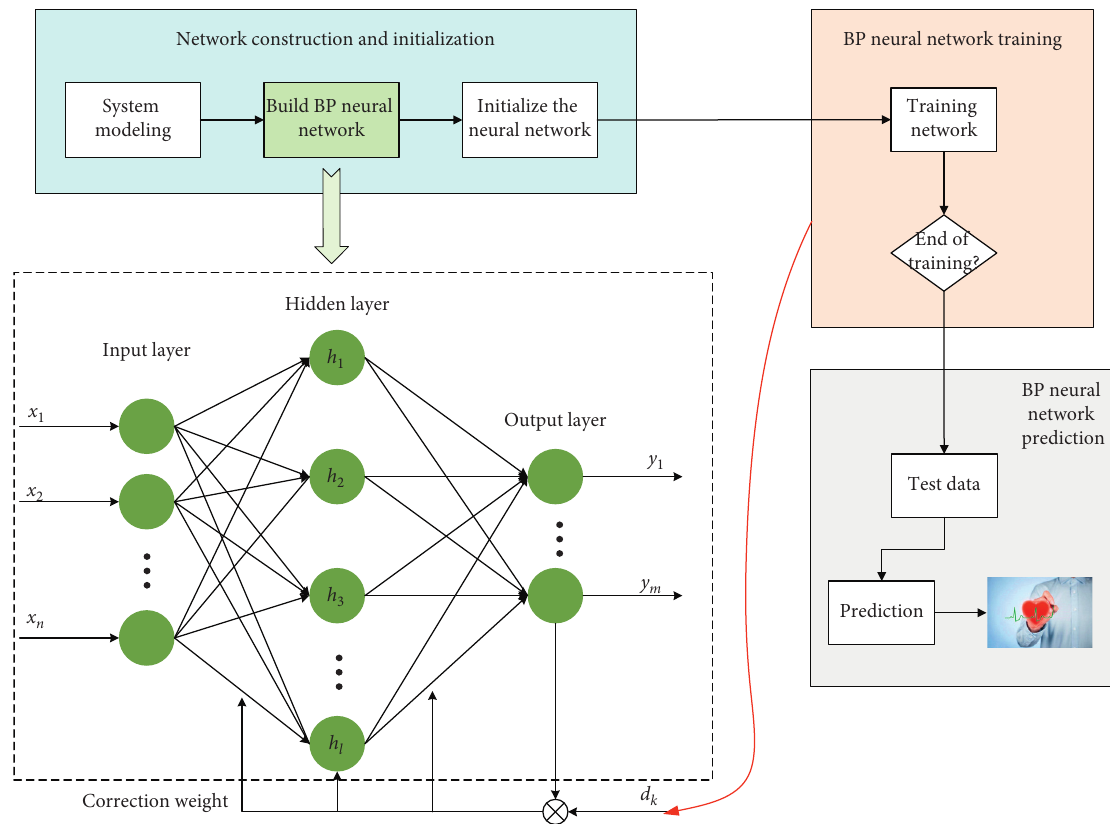
Figure 3: BP neural network (BPNN) algorithm structure and